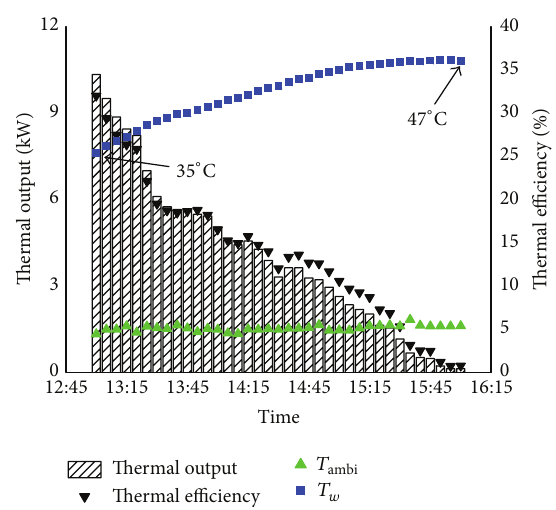
Figure 11: Thermal performance of the HCPV/T